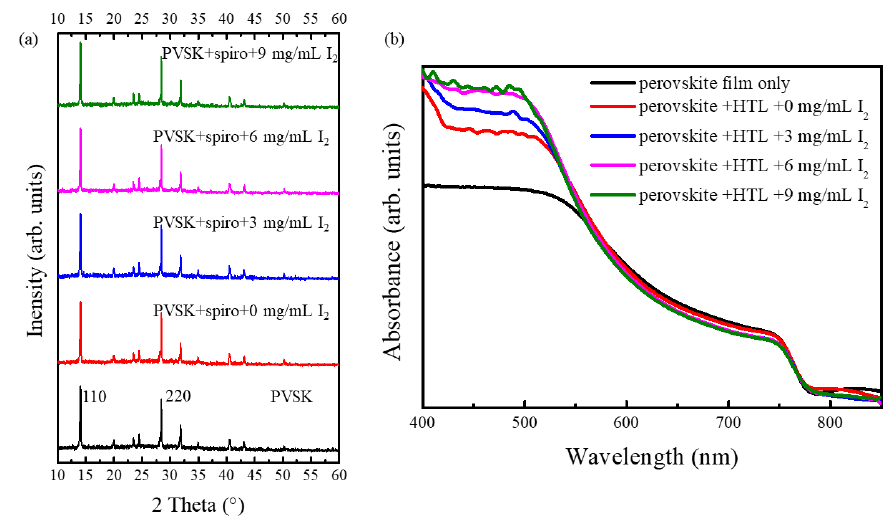
Figure 1. ( a ) XRD patterns of MAPbI 3 thin film after coating with doped spiro-OMeTAD hole transport layer (HTL) layers; ( b ) UV–vis absorption of perovskite intrinsic film and with different doped spiro-OMeTAD HTL layers.